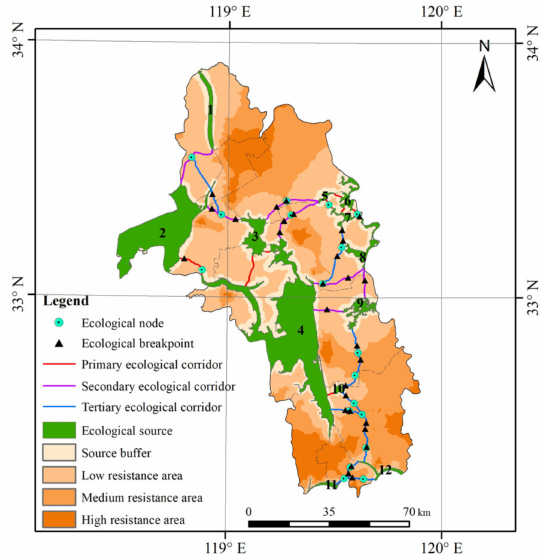
Figure 9. Spatial distribution of the ecological